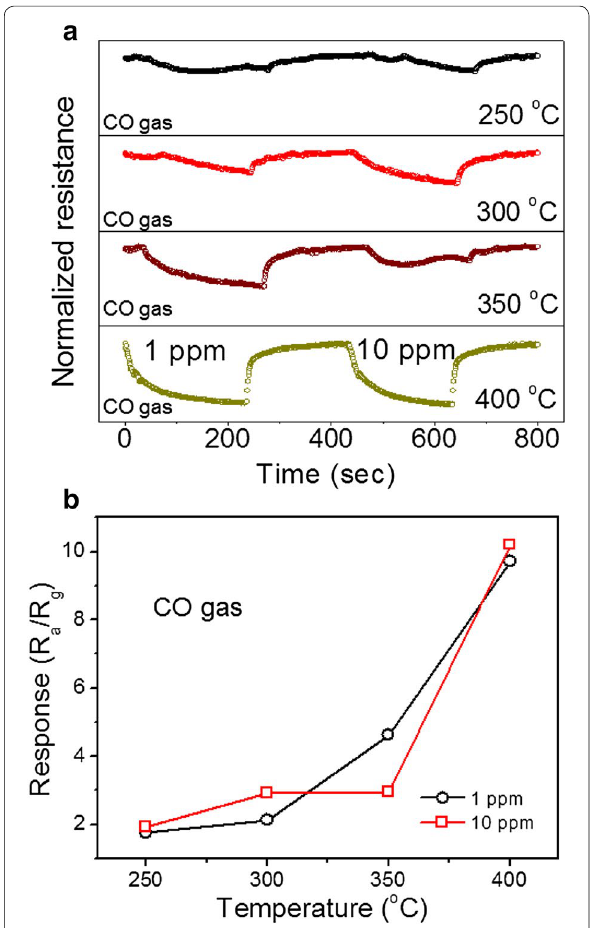
Fig. 3 a Normalized resistance curves of hollow ZnO NW sensor with surface area of 10.17 m 2 g − 1 towards 1 and 10 ppm CO gas at dif‑ ferent temperatures. b Corresponding response versus temperature plots for 0.1 and 1 ppm CO gas